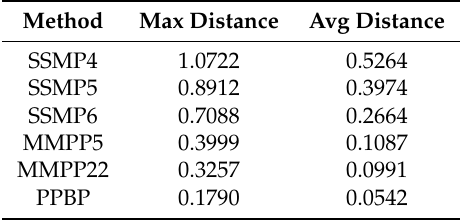
Table 1. The comparison of distances between calculated values, and the fitted values provided by the method of least squares. SSMP: special semi-Markov process; MMPP: modulated Markov Poisson process; PPBP: Poisson Pareto burst